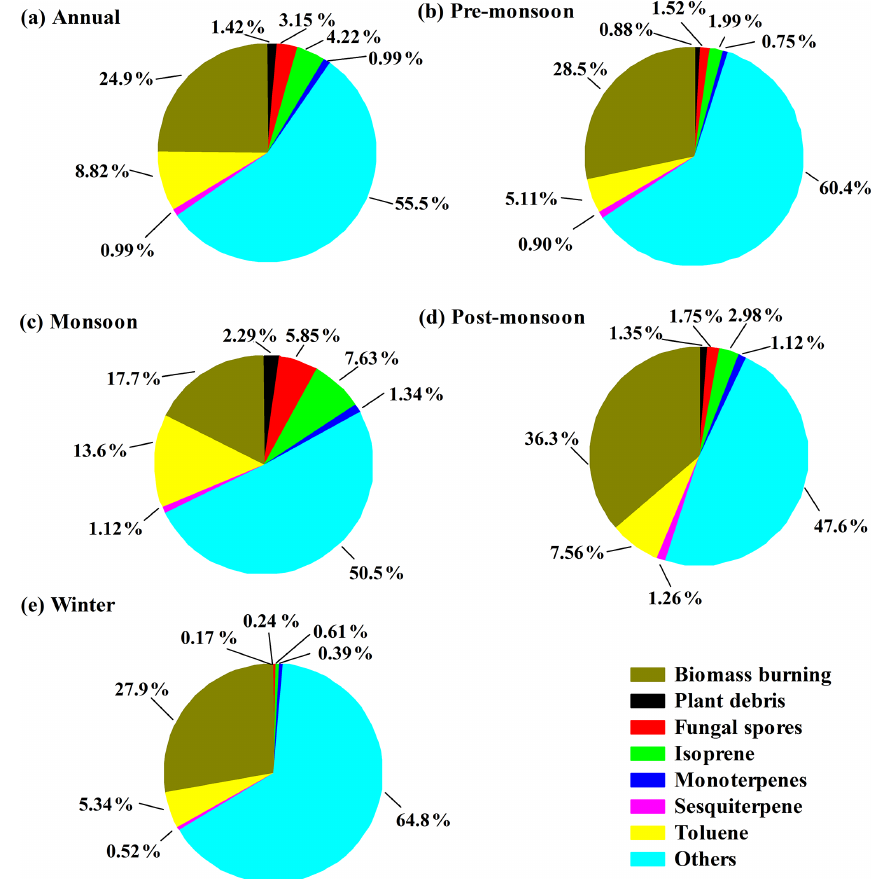
Figure 11. Pie-charts showing contributions from different sources to OC based on the estimation of tracer-method in Bode, Kathmandu Valley: (a) annual, (b) pre-monsoon, (c) monsoon, (d) post-monsoon, and (e) winter.